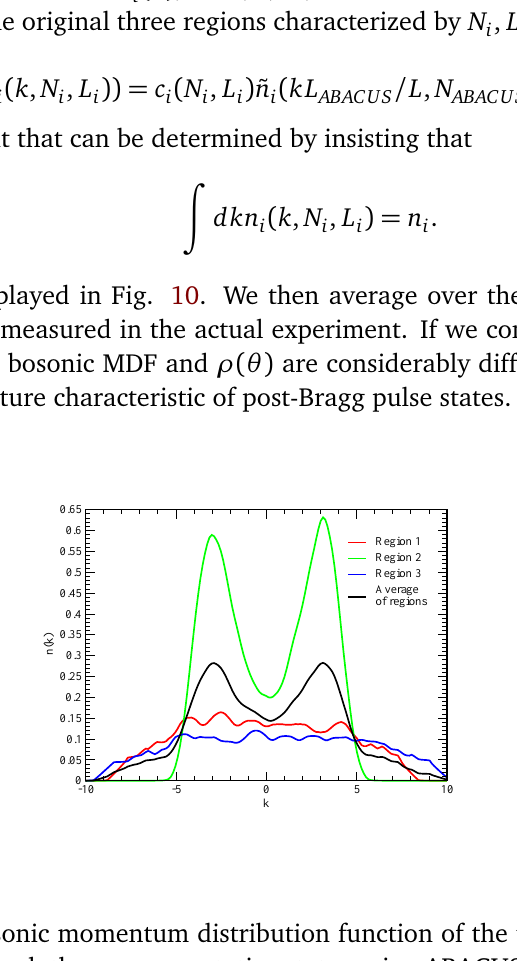
Figure 10: Bosonic momentum distribution function of the trapped gas at t = 10 τ , computed through three representative states using ABACUS (see text). The charac- teristic double-peak structure of the post-Bragg pulse state is clearly